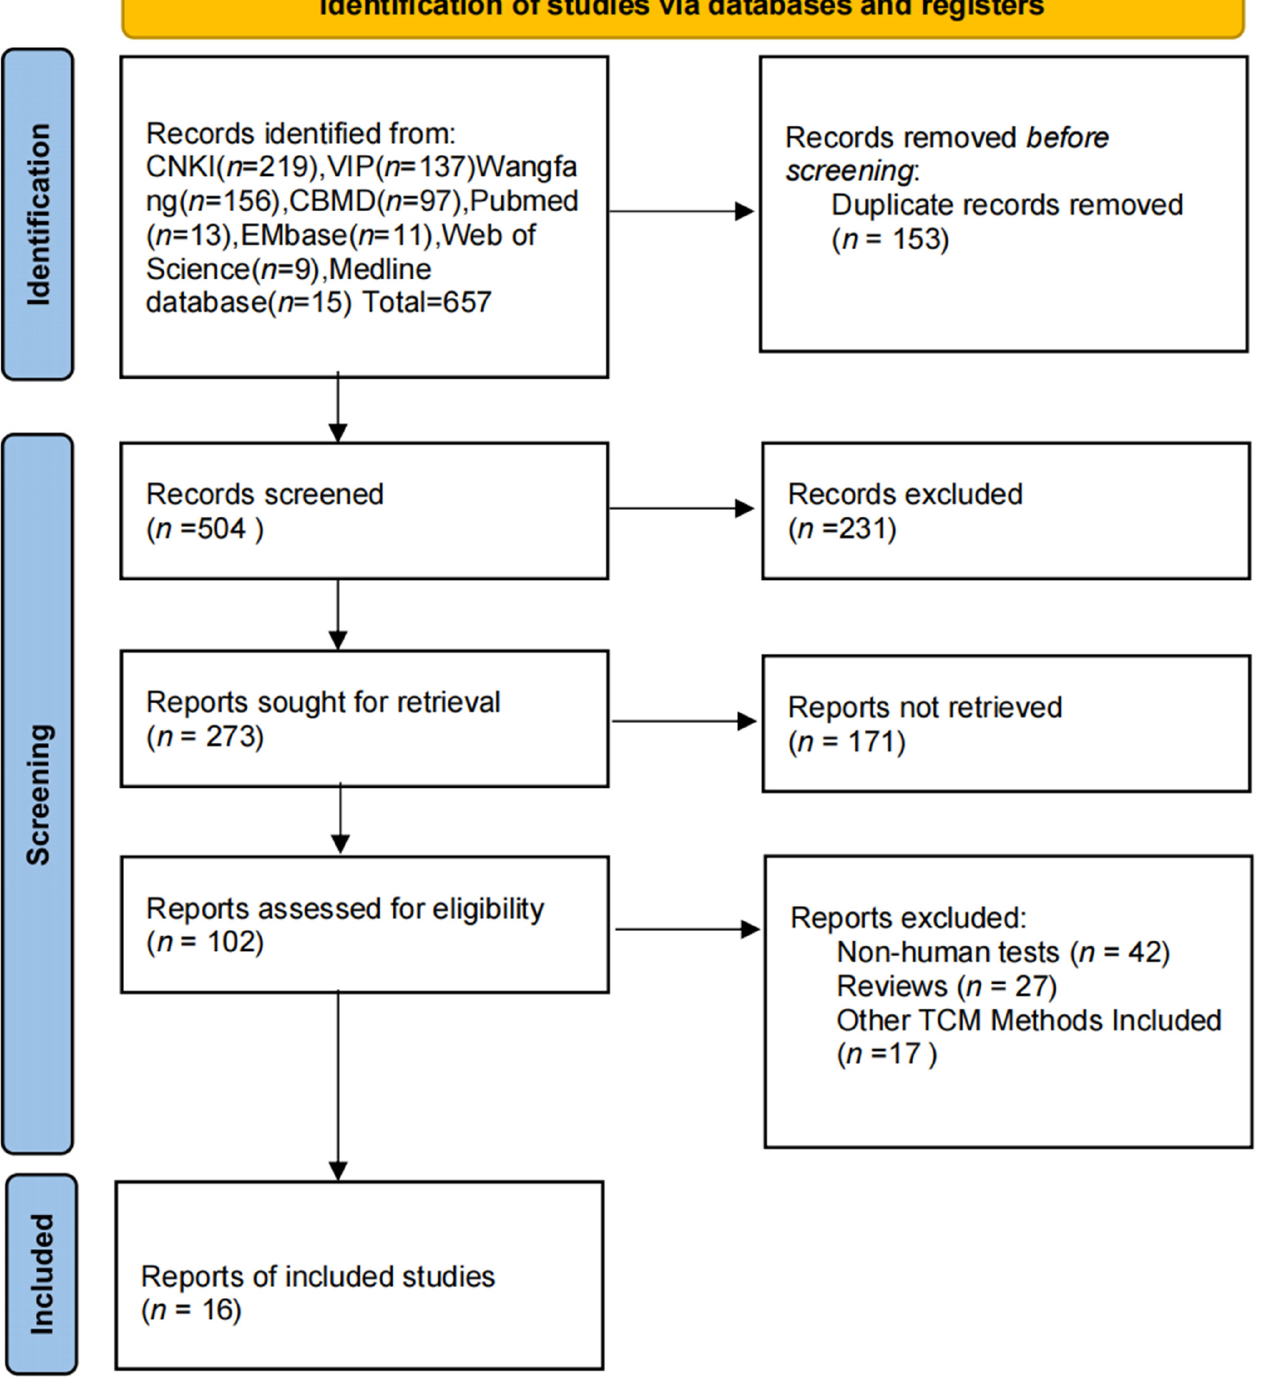
Figure 1. Flow chart of literature screening. Table 1. Basic characteristics of the included literature.